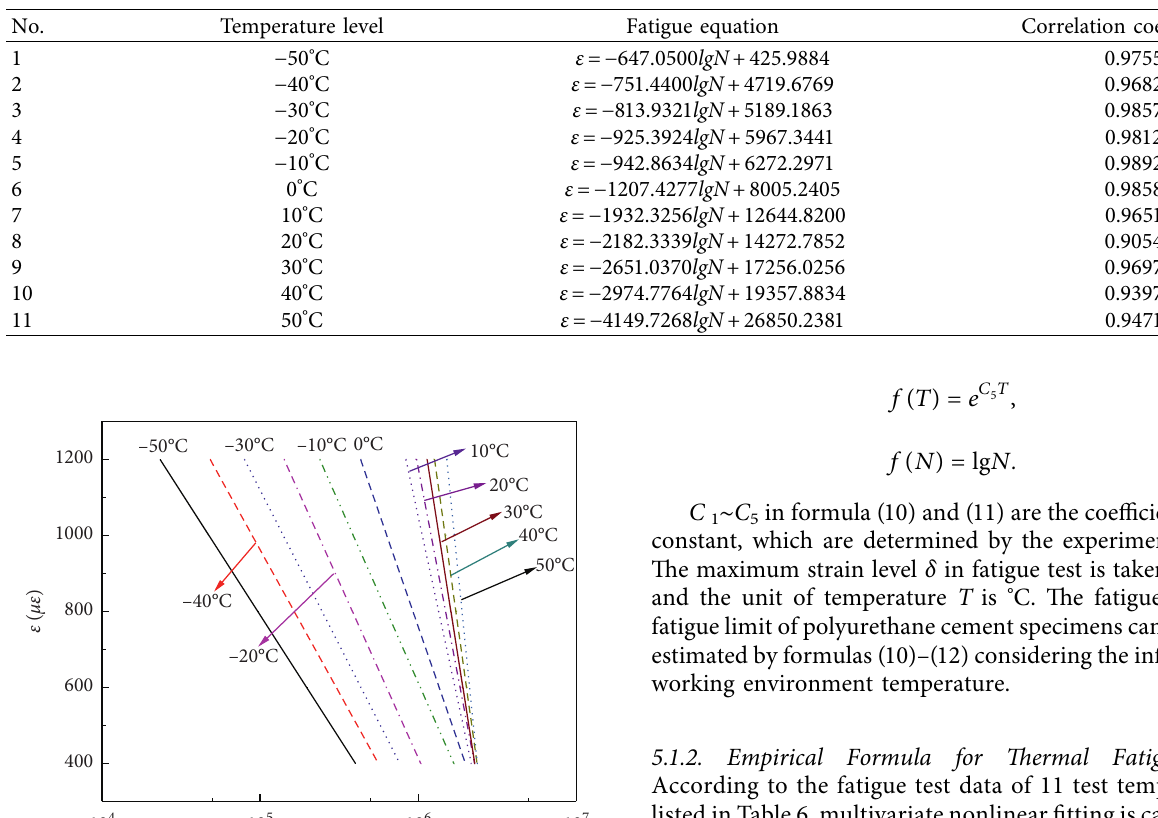
Table 7: Bending fatigue equation of polyurethane cement.